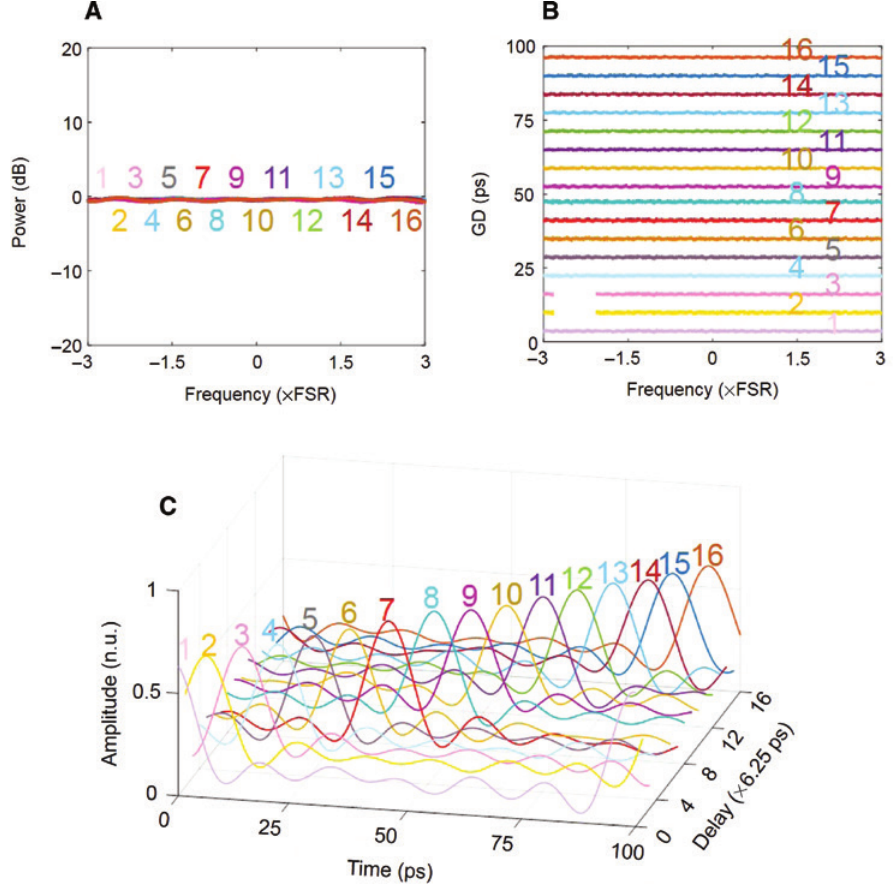
Figure 9: The measured delay responses in the frequency domain, group delay (GD) and an experimental verification of its applicability to a narrow optical pulse with a duration of 1.2 ps, i.e. a bandwidth of 0.4 THz. (A) Frequency responses and (B) group delays of the programmable filter when tuning the GD ranges from 0 to 93.75 ps with a tuning step of 6.25 ps. (C) Impulse responses of the filter for different delay cases when the input is 1.2-ps pulses for 16 GD